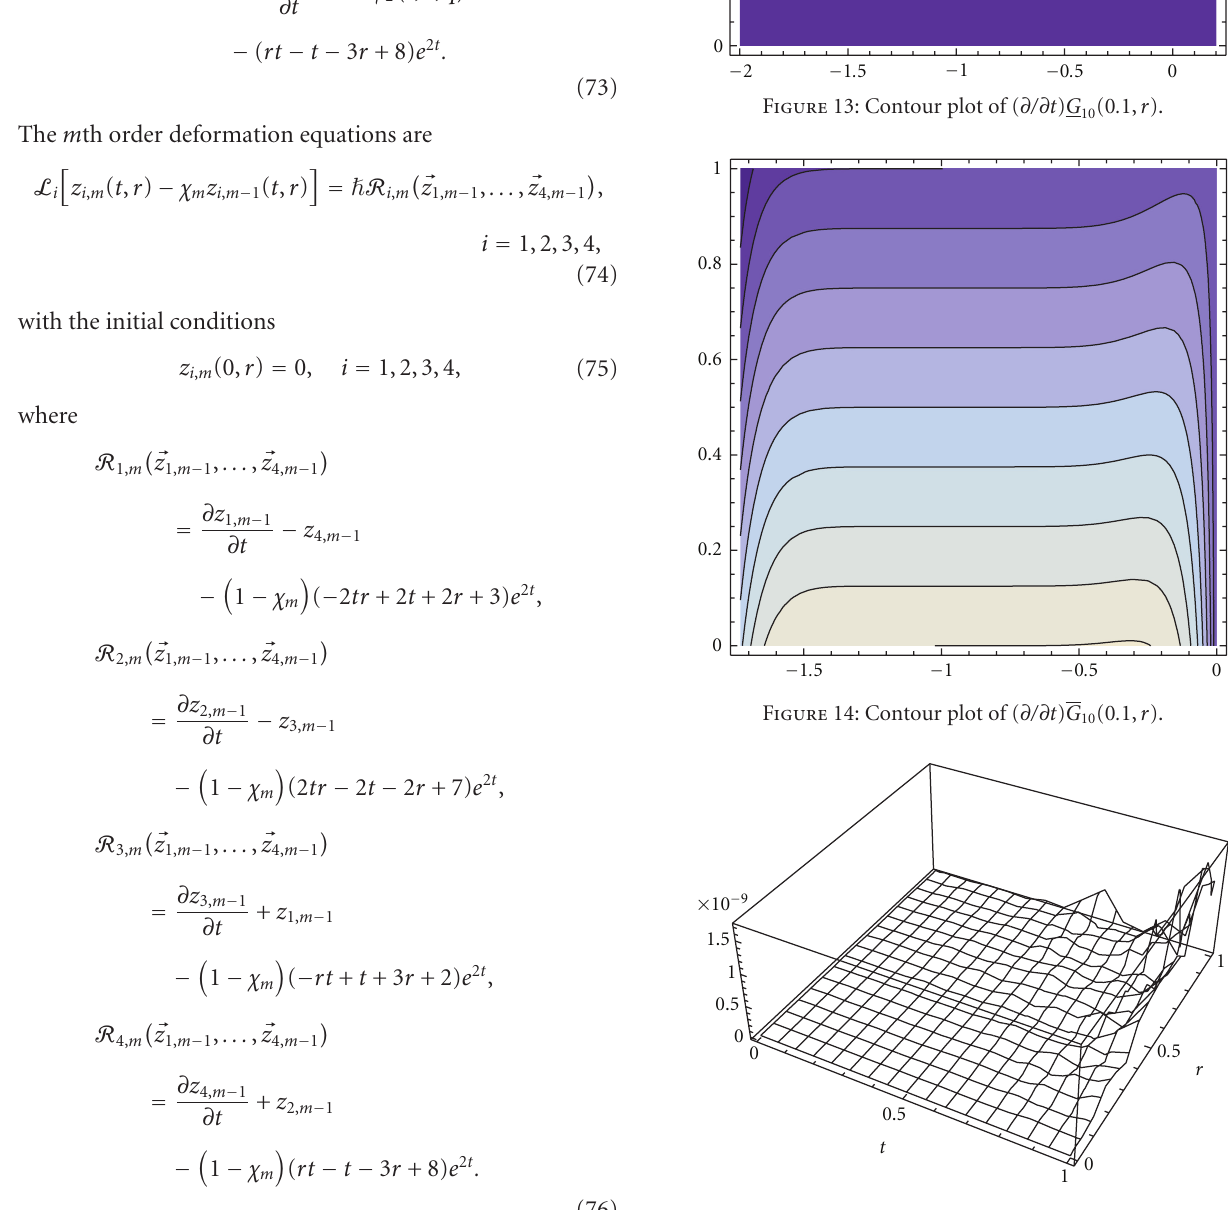
Figure 15: Absolute error of Y